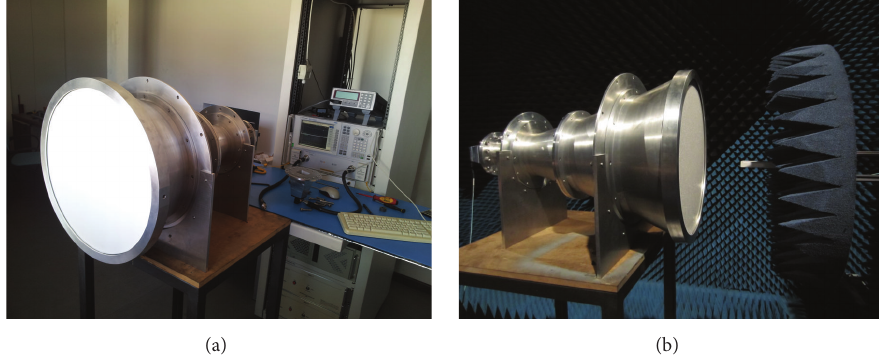
Figure 8: Measured port reflection (a) and radiation pattern (b).